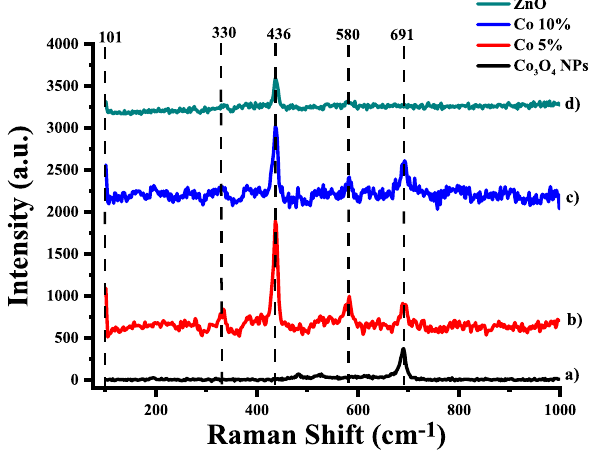
Figure 9. Raman spectra of ( a ) Co 3 O 4 NPs, ( b ) Co 5%, ( c ) Co 10% and ( d ) ZnO